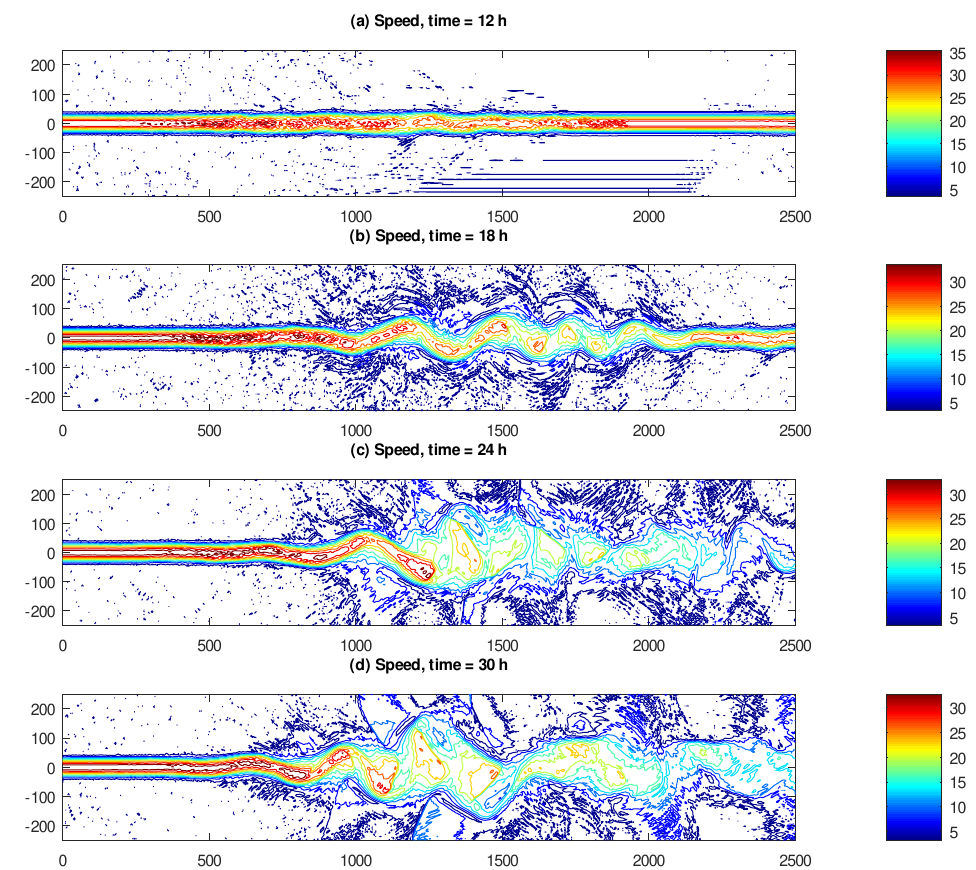
Figure 1. Speed of the inertial flow, expressed in m/s, and captured at ( a ) 12, ( b ) 18, ( c ) 24 and ( d ) 30 h of elapsed model time. The domain size is 2500 × 500